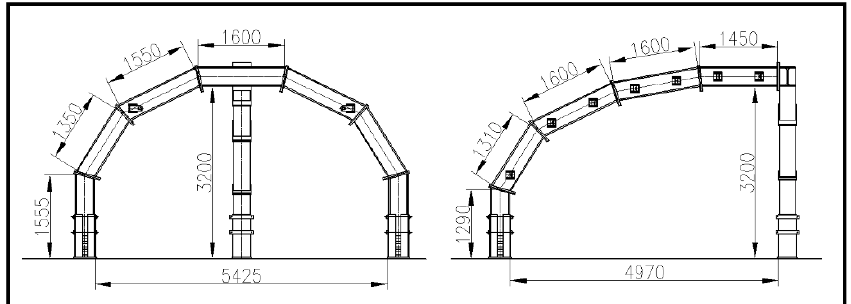
Figure 19. The structure of the branch casing-portal and cantilever.